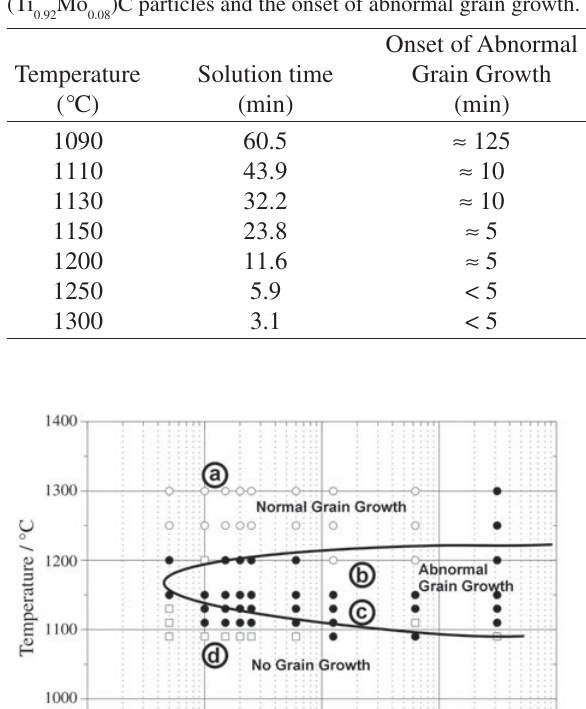
Table 3. Comparison between the dissolution times of Table 2. Solution times (in seconds) calculated for M C and 23 6